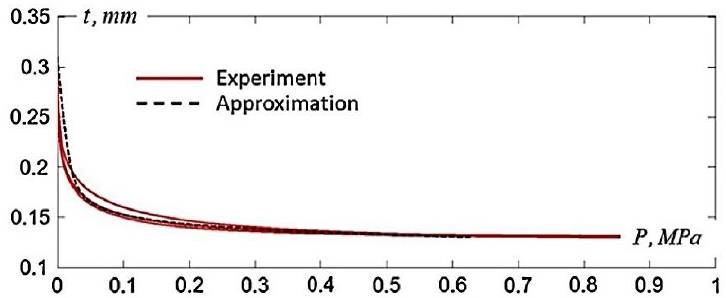
Figure 9. Thickness-compressive pressure of a dry carbon yarn [23].